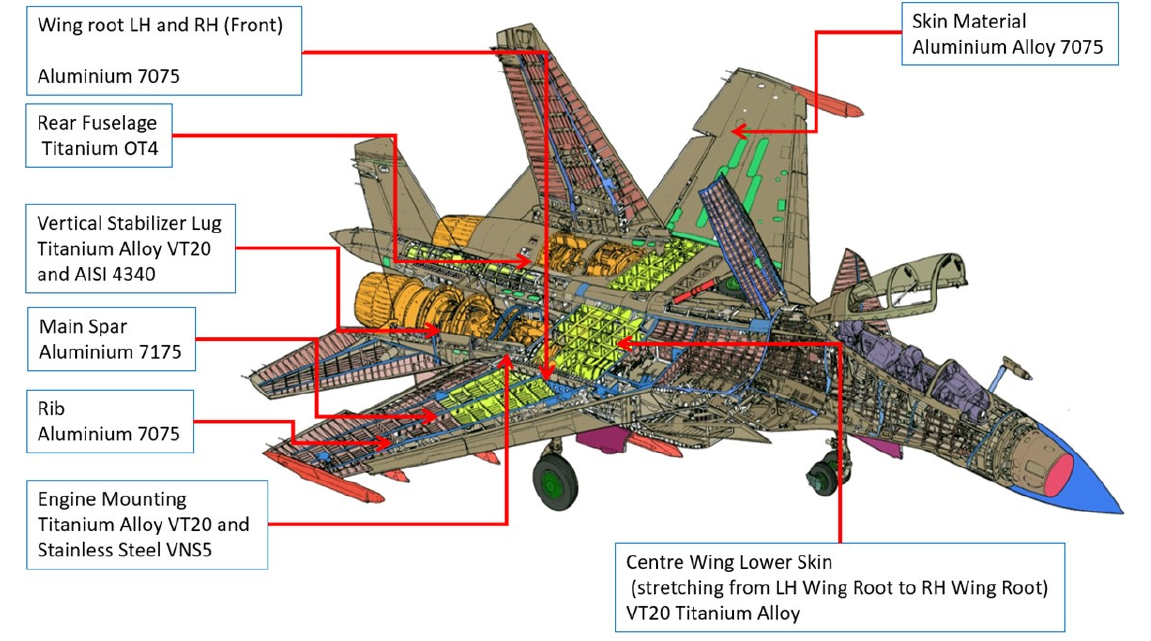
Figure 3. The material composition of the Su-30MKM structure.